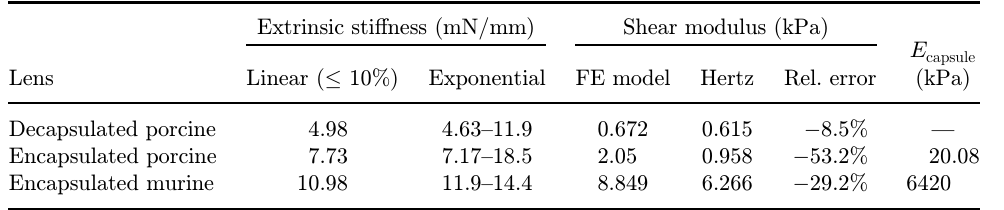
Table 1. Sti®ness and shear modulus estimates.